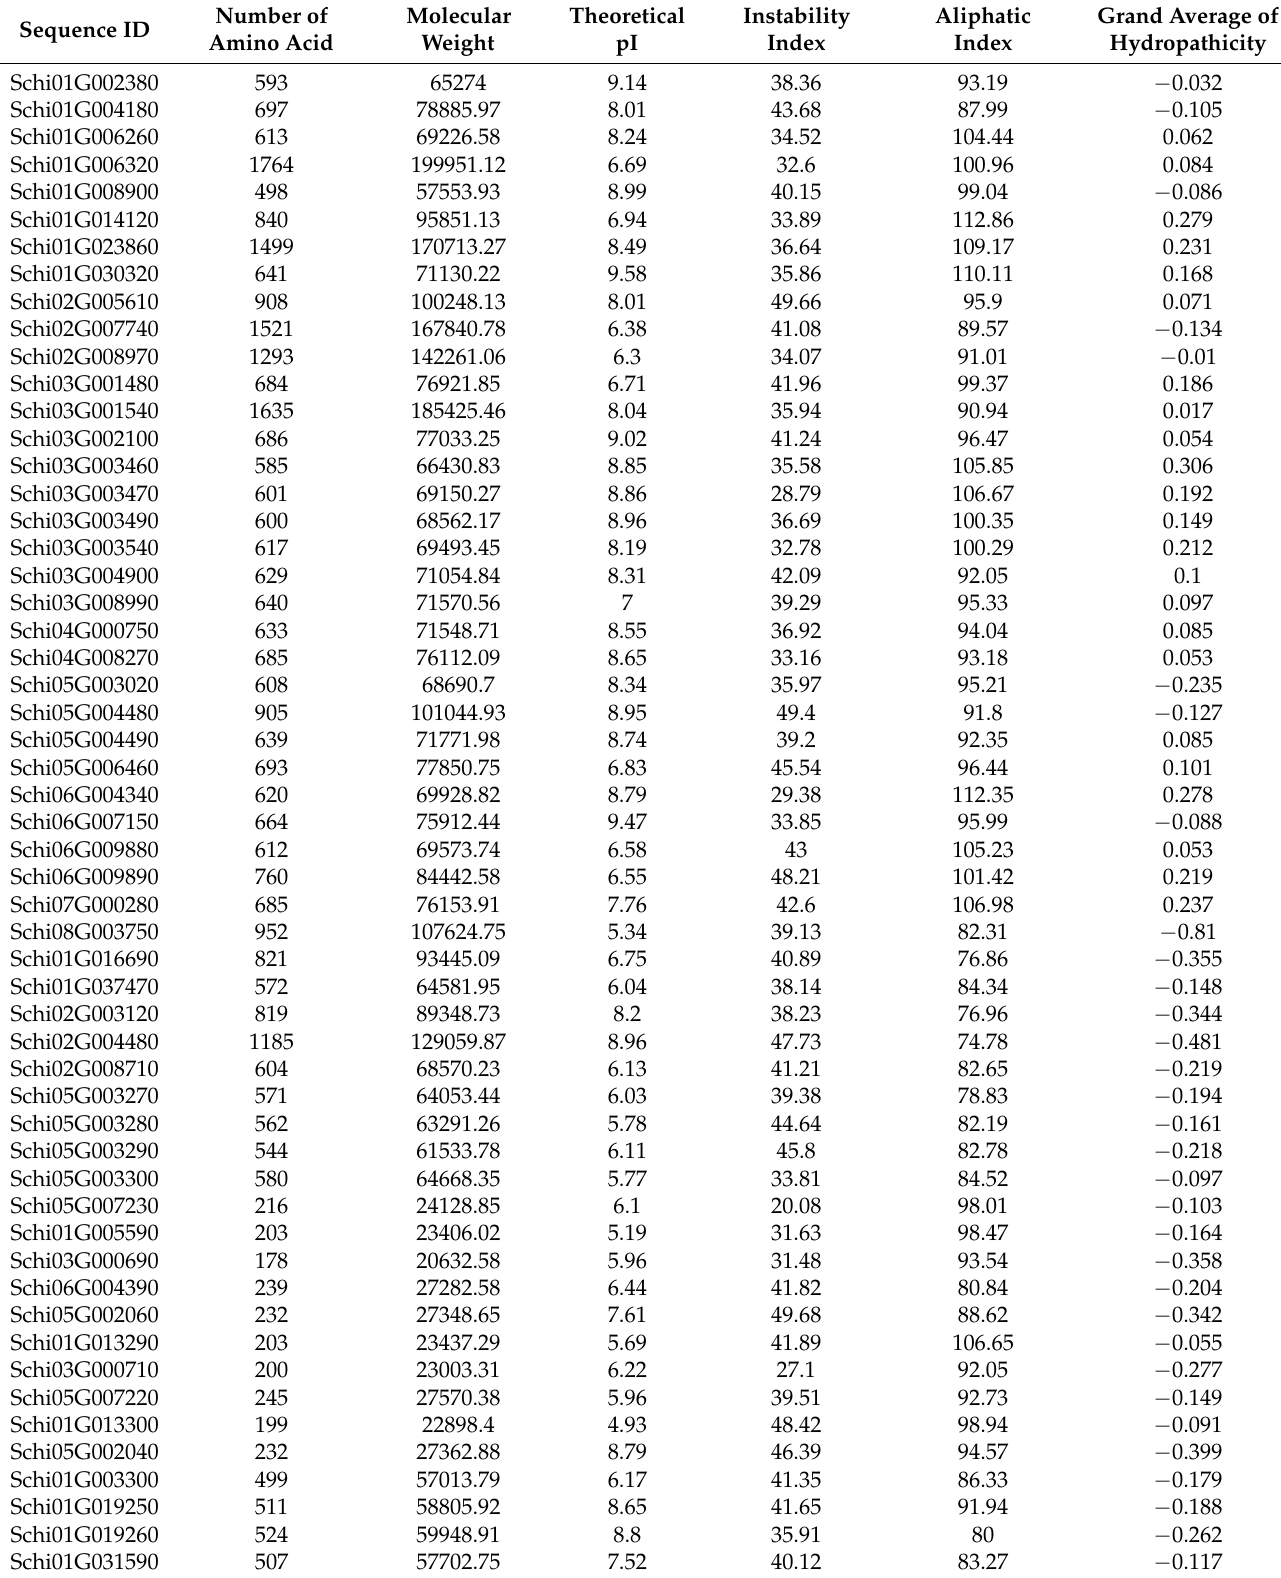
Table 4. General information and physicochemical properties of detoxification gene family products in S. chinensis